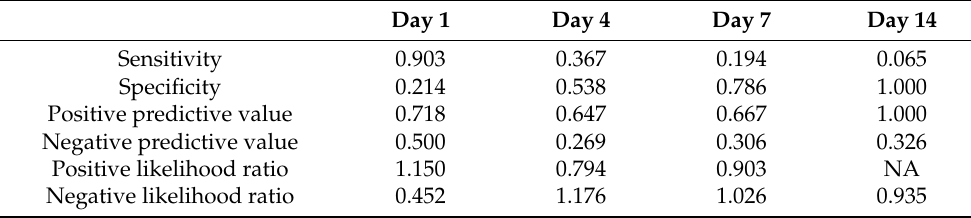
Table 1. The predictive value of cell visibility for successful corneal deturgescence.